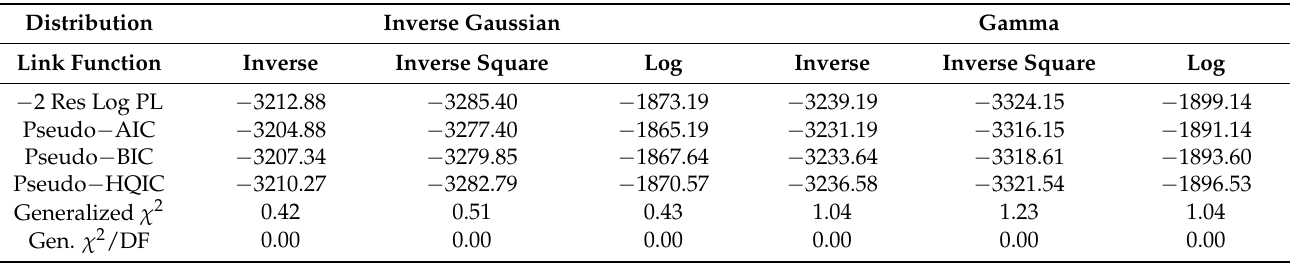
Table 1. Summary results to compare and select the best distribution and link functions for grain yield analysis.